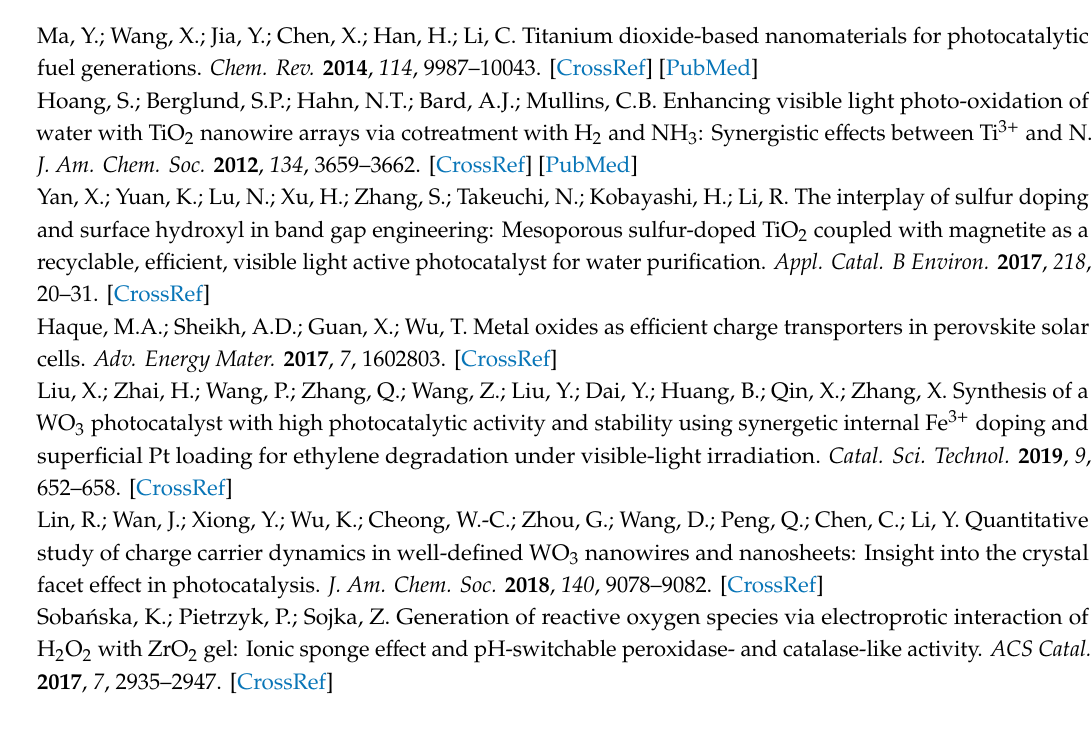
Figure S1: Confirmation of NPs. Figure S2: NPs tracking